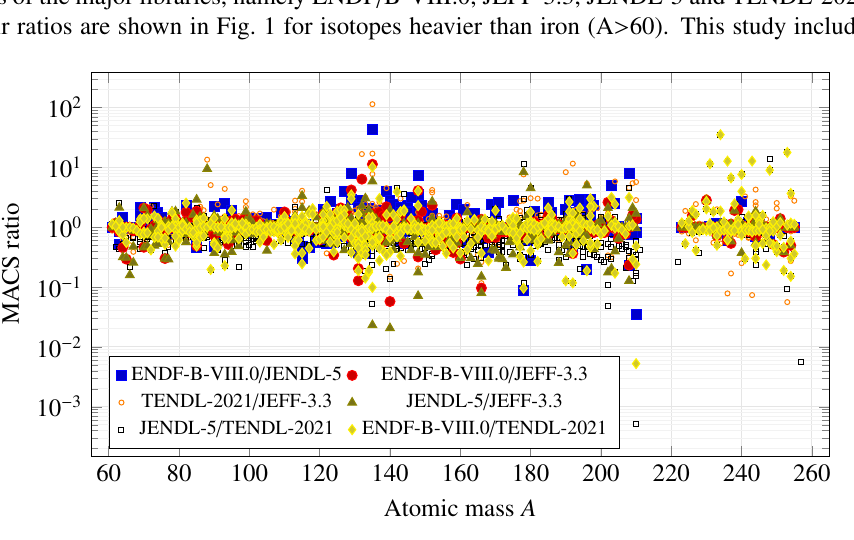
Figure 1. Ratio of MACS at kT = 8 keV obtained from major nuclear data libraries. Large deviations are observed for metastable states and short-lived